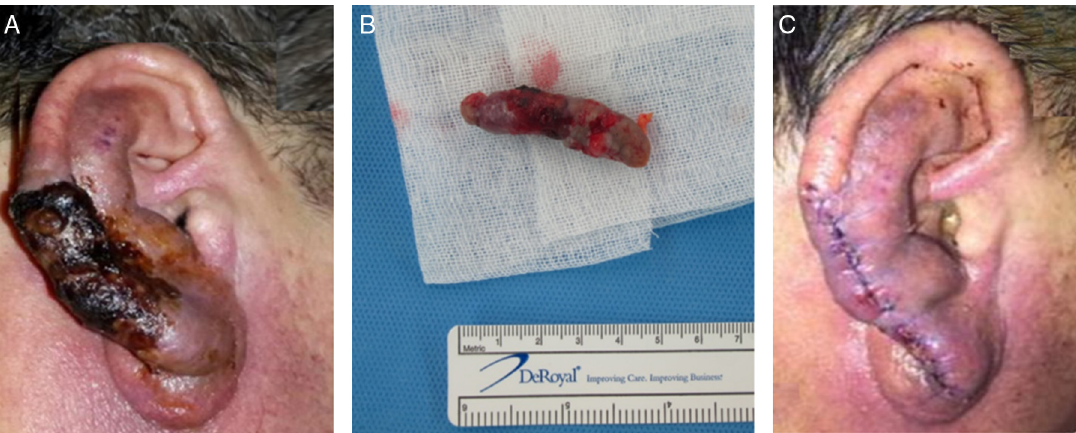
Figure 3 Gross ear findings at 2 weeks after embolization and total excision of the arteriovenous malformation. (A) Two weeks after transarterial embolization, the boundary of the necrotic skin lesion became distinct. (B) The necrotic skin and the mass of the arteriovenous malformation was excised under local anesthesia. The dimensions of the mass were 4.8 cm × 1.2 cm × 1.2 cm. (C) The auricle was closed under minimal tension.